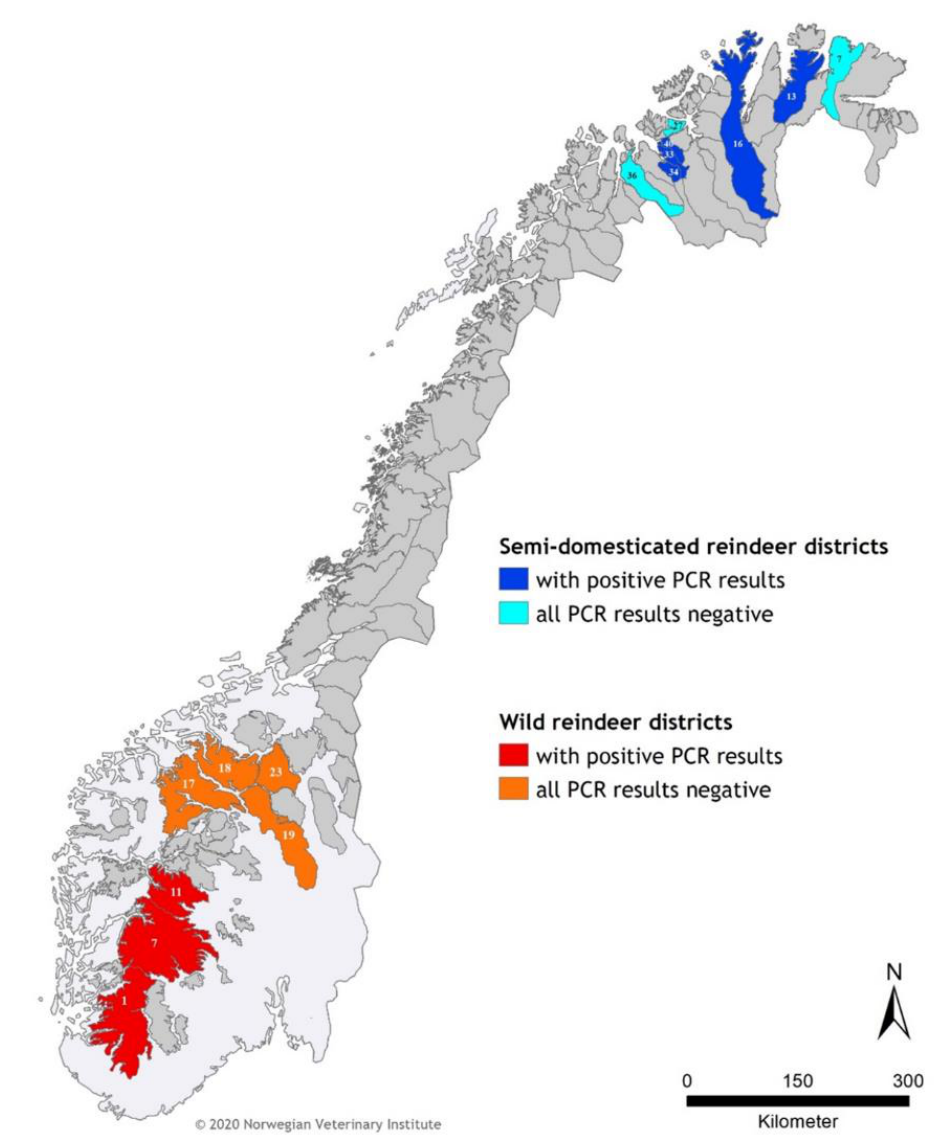
Figure 2. Location of the wild and semi-domesticated Eurasian tundra reindeer ( Rangifer tarandus tarandus ) samples tested in this study. The map depicts in red/orange wild reindeer management areas, and in dark/light blue semi-domesticated reindeer husbandry districts. Numbers in the areas/districts refer to information from Table 1.